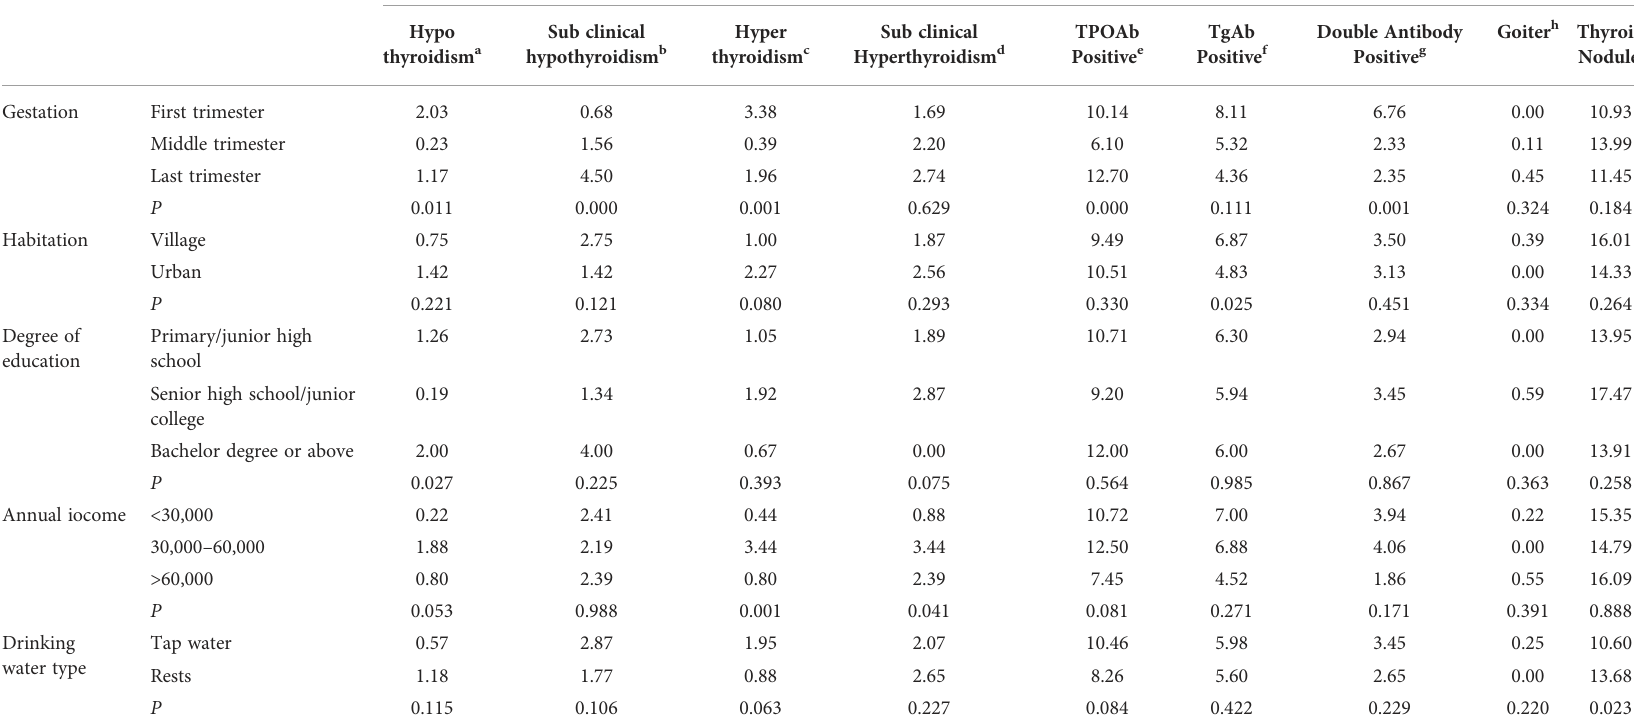
TABLE 7 The in fl uencing factor of thyroid diseases for pregnant women.